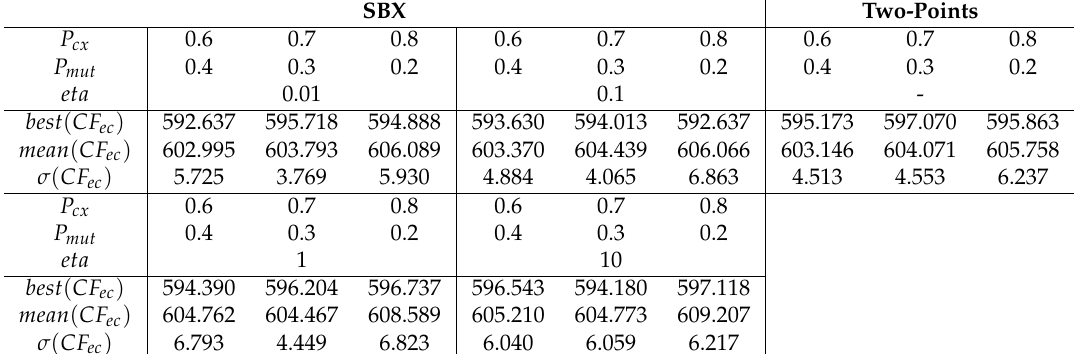
Table 6. Case-study 1 results, expressed in e .